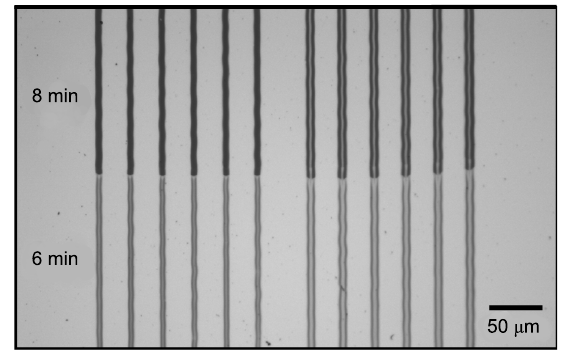
Figure 8: Optical micrograph of a laser-patterned HDT SAM on a Au/ glass substrate exposing a 10 nm thick Au layer after wet-chemical etching. The micrograph displays surface areas that have been dipped into the etchant for 6 min (bottom) or 8 min (top).